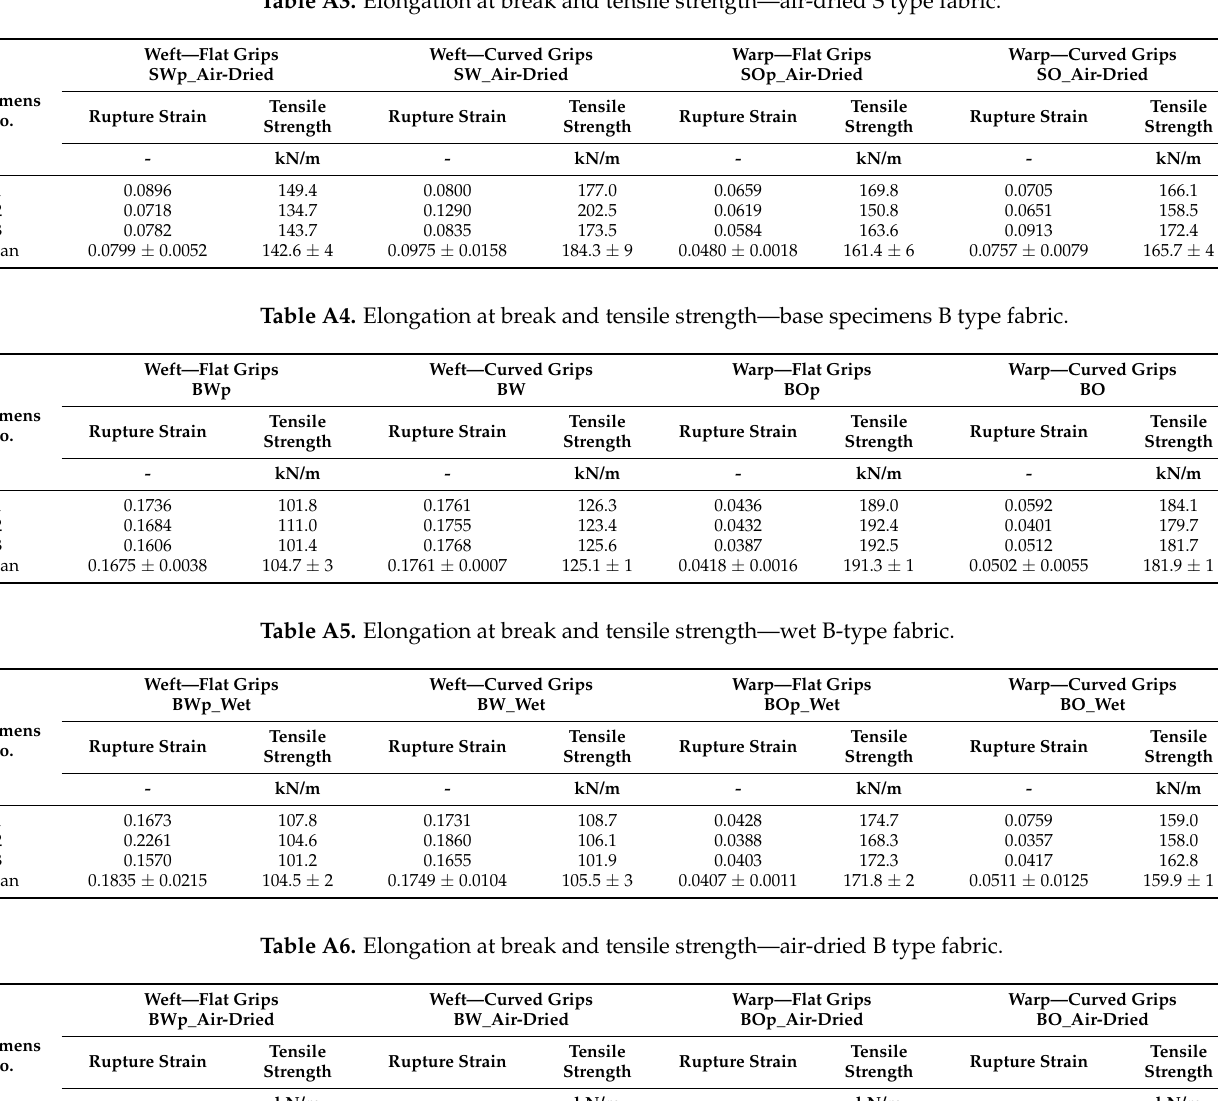
Table A3. Elongation at break and tensile strength—air-dried S type fabric.